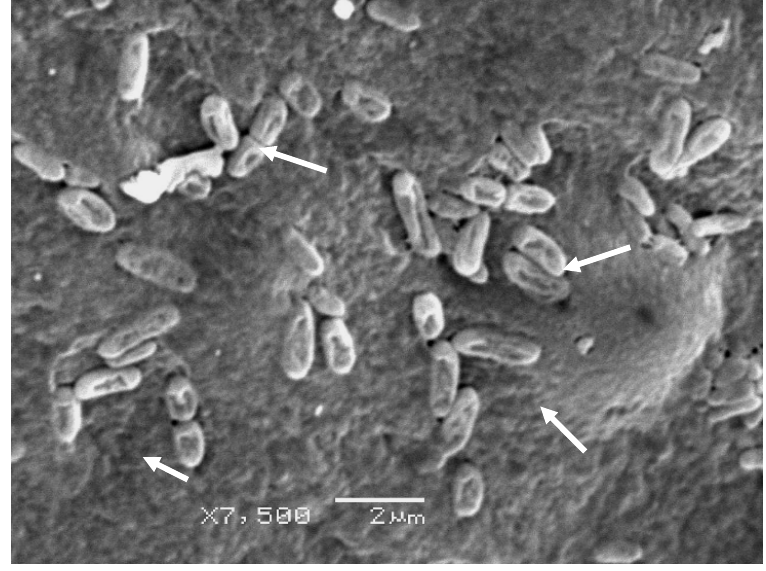
Figure 2. The treated cells ( Shigella sp . ) are shrinking. Note the cytoplasm loss and depressed cell walls